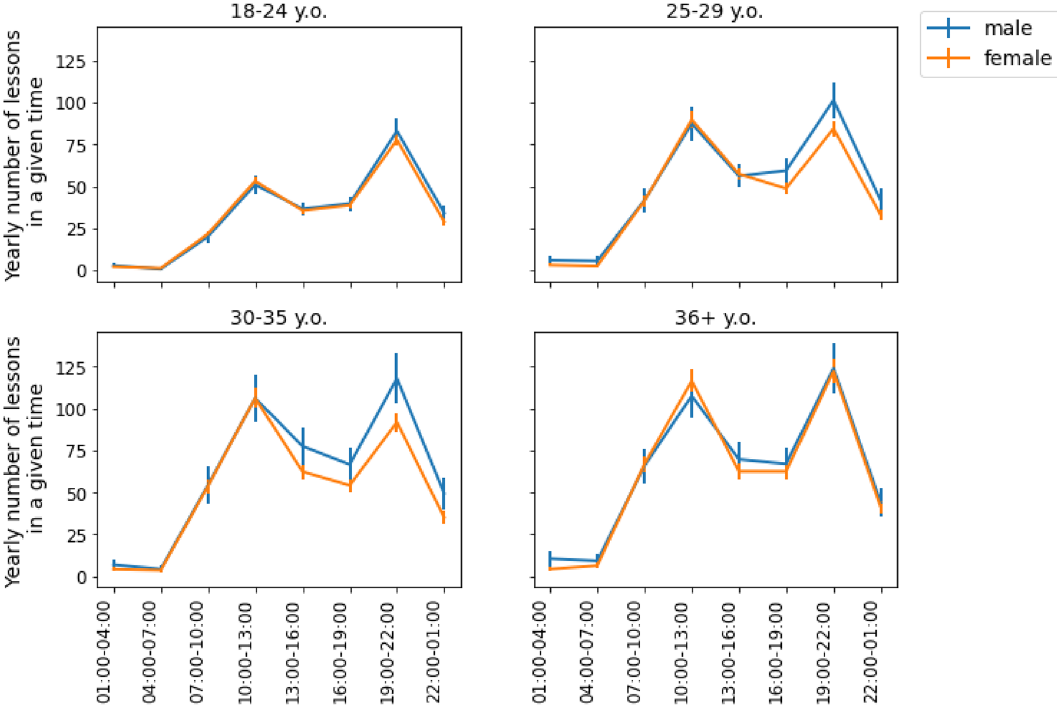
Figure 5. Average yearly teaching workload in 2019 for four different age categories. Vertical bars correspond to 95% confidence intervals. Skyeng’s male teachers had a higher workload than its female teachers notably in two age groups: 25–29 and 30–35.